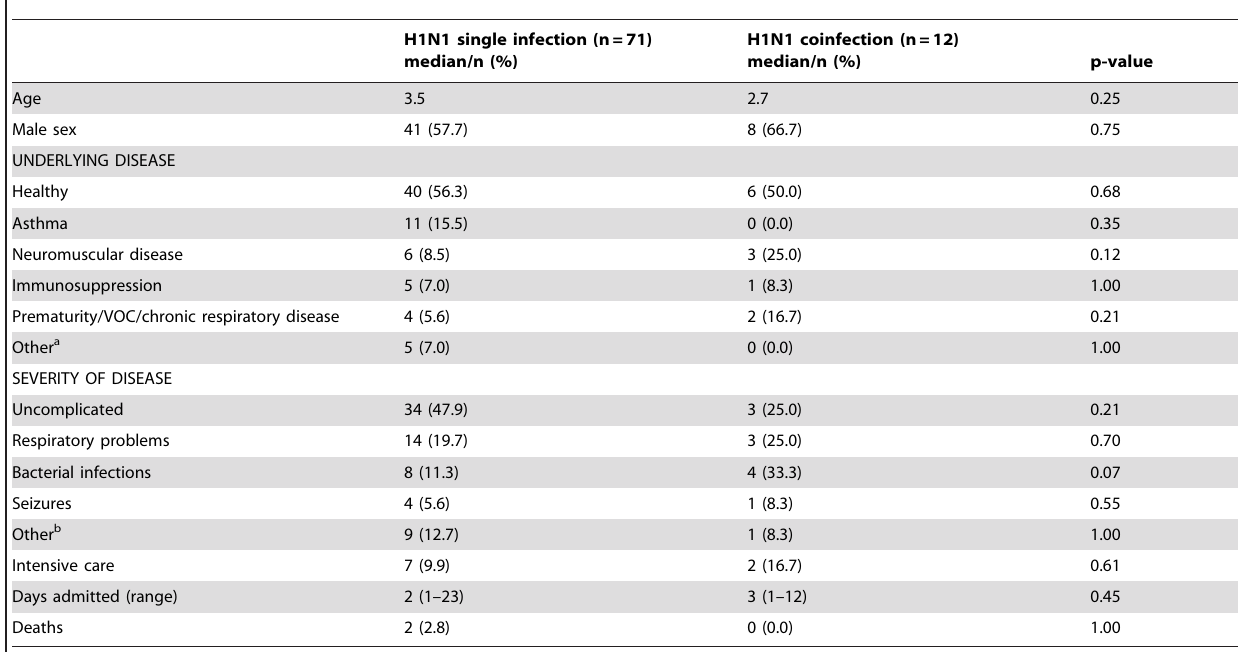
Table 3. Severity of disease and underlying conditions in children admitted with influenza-like illness.